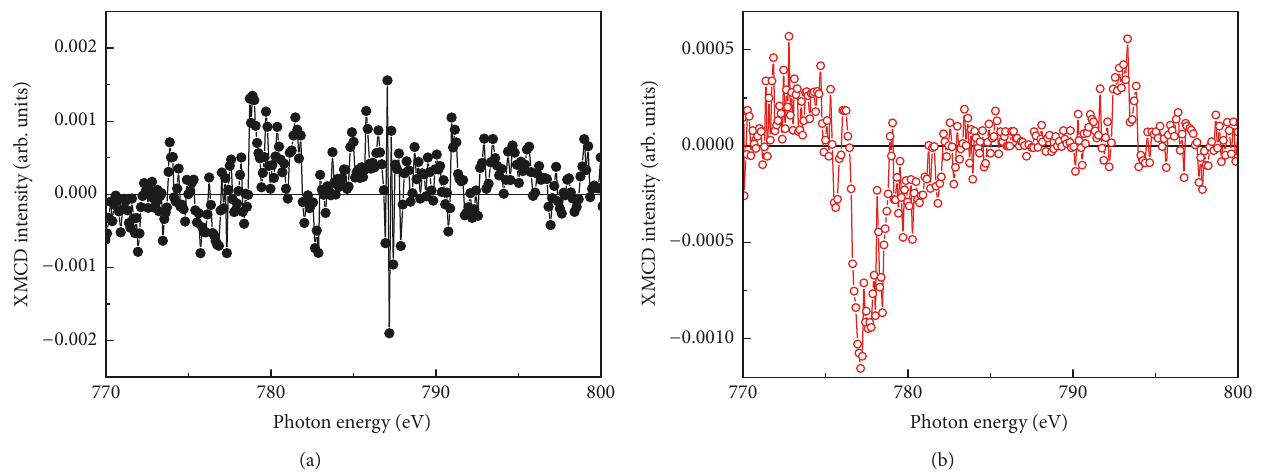
Figure 6: (a) TEY and (b) FY XMCD spectra at 2 K held at remanence for a Co-doped ITO film annealed at 975 K.